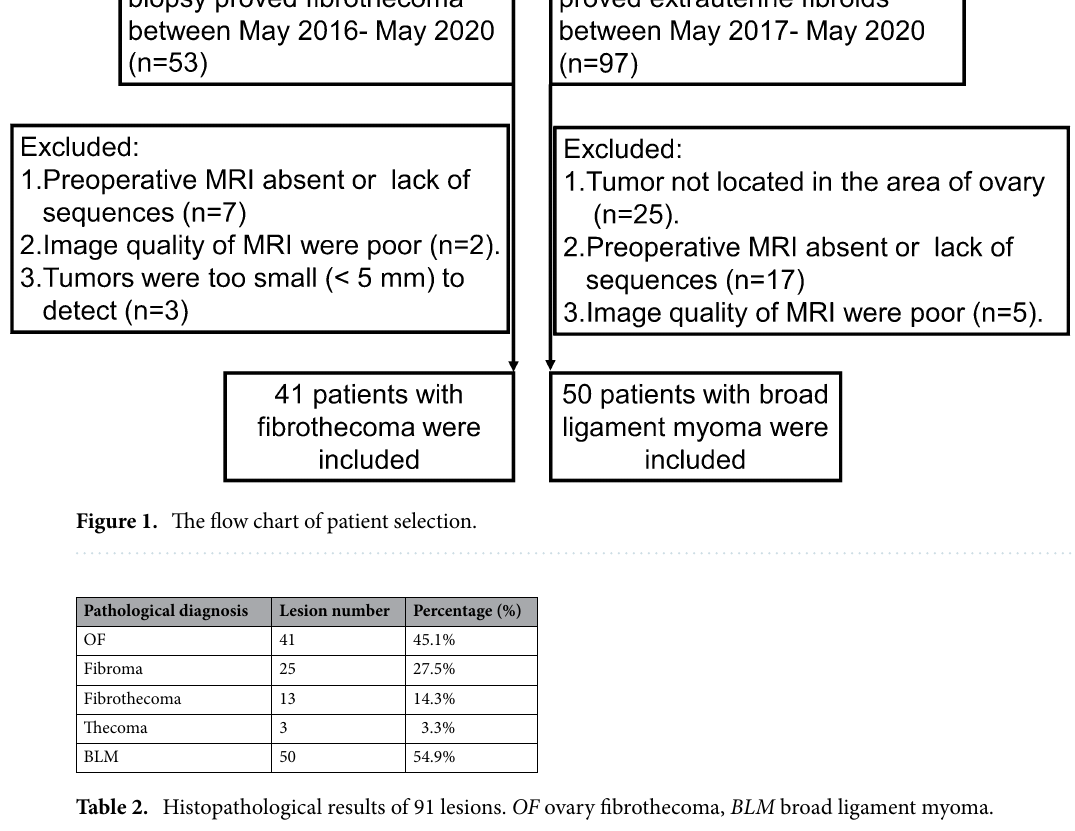
Table 2. Histopathological results of 91 lesions. OF ovary fibrothecoma, BLM broad ligament myoma.